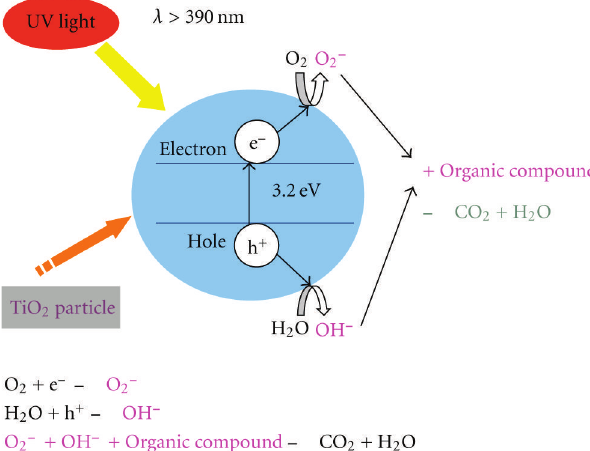
Figure 13: Cathodic protection system using UV